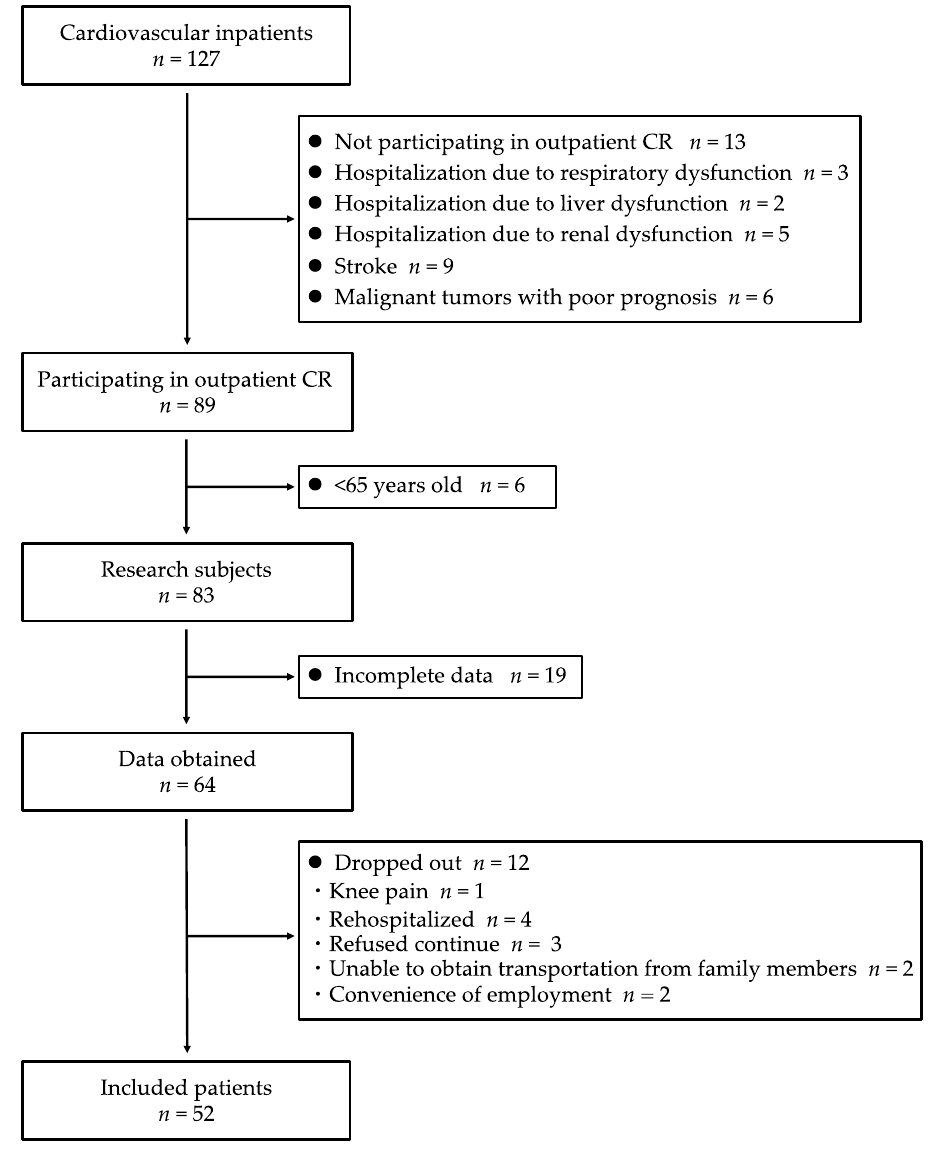
Figure 2. Flow chart of participant inclusion. Of the 127 patients admitted to the cardiology depart- ment of our hospital between August 2019 and December 2019, 52 were included in the study. CR, cardiac